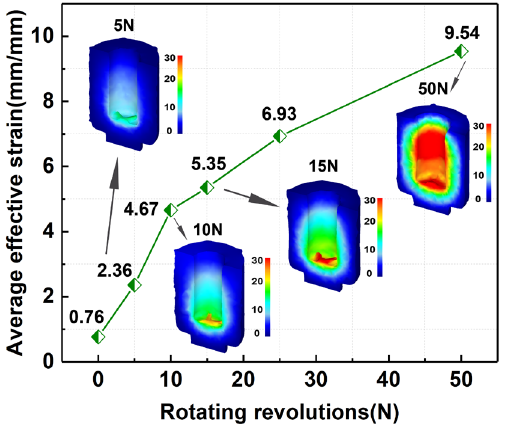
Figure 4. Variation of average effective strain and strain distribution of the extruded samples with number of revolutions (N).